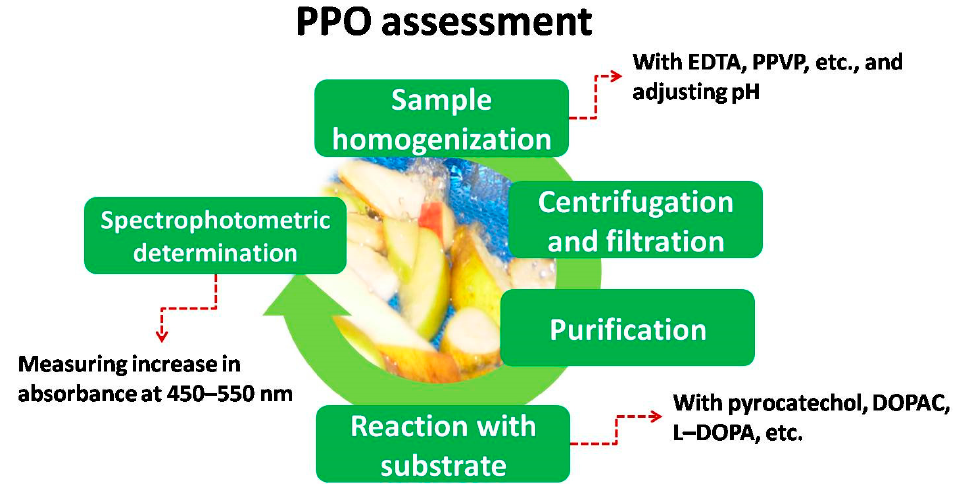
Figure 5. Steps for PPO assessment. Table 1. Different conditions for PPO activity determination in some fresh-cut